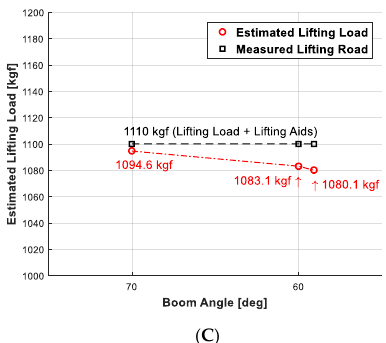
Figure 17. Experiment outputs (estimated lifting load and measured lifting load). ( A ) 390 ( + 110) kgf; ( B ) 500 ( + 110) kgf; ( C ) 1000 ( + 110) kgf.